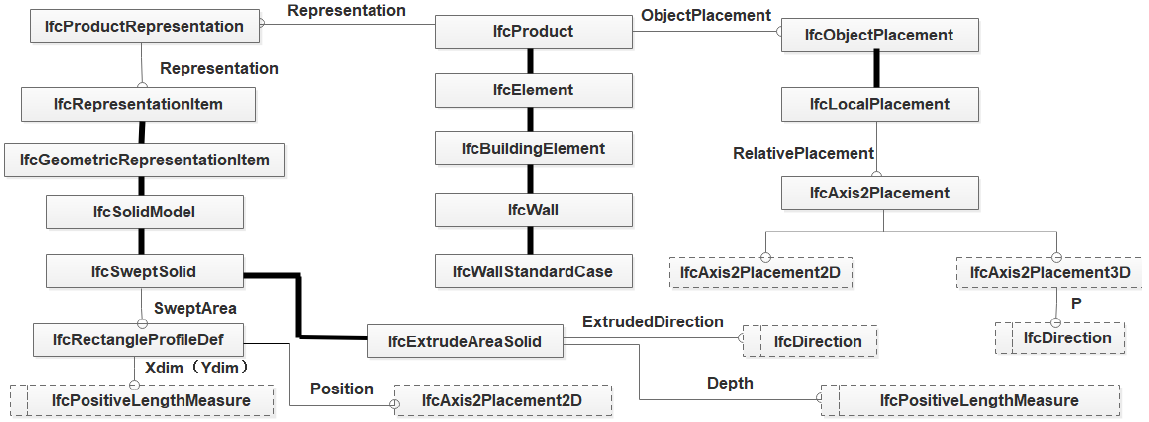
Figure 4. Method of extracting entity information of spatial model based on IFC.